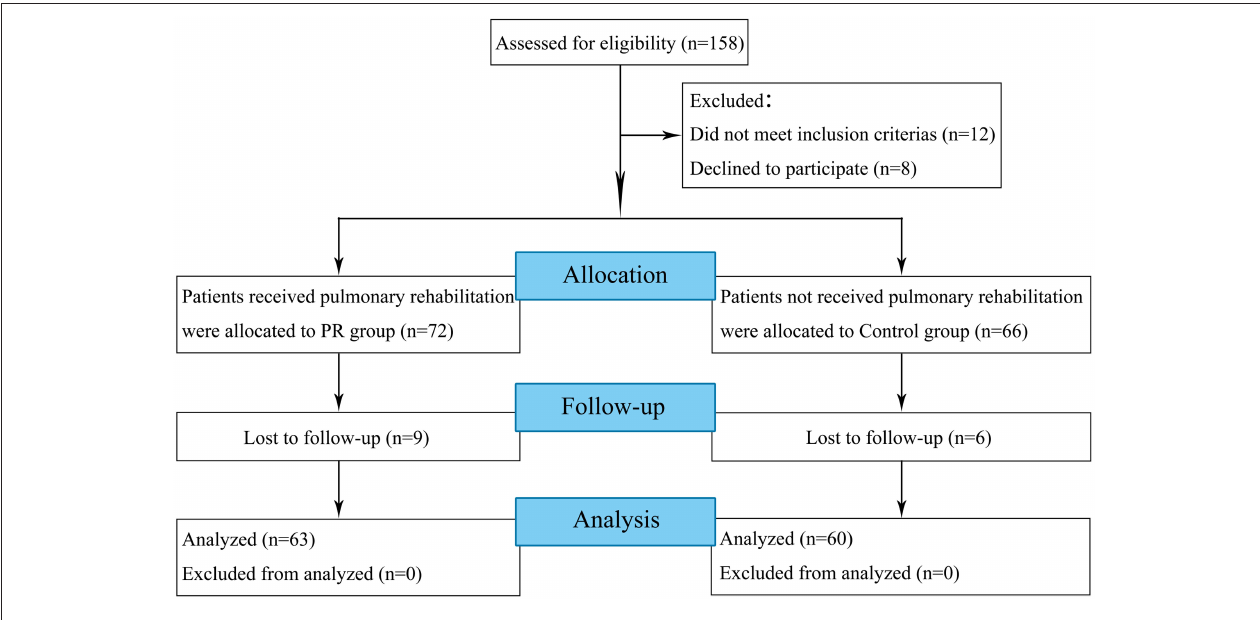
FIGURE 1 | Flow diagram of the study design.